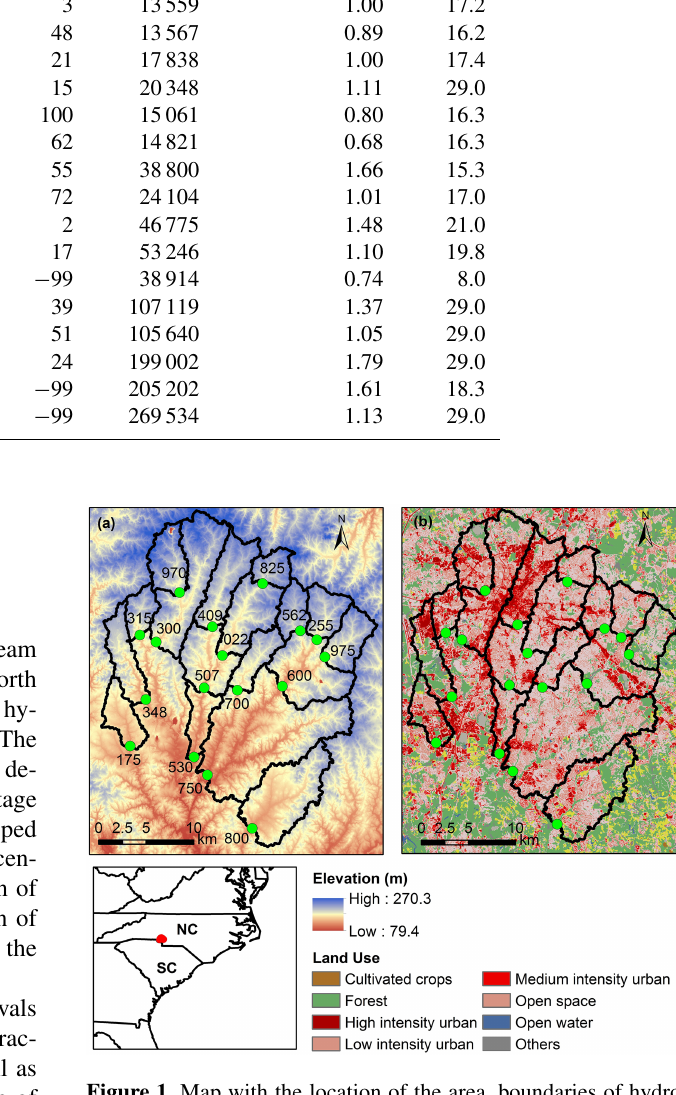
Figure 1. Map with the location of the area, boundaries of hydro- logical basins and location of stream gauges used in the analysis. NC: North Carolina. SC: South